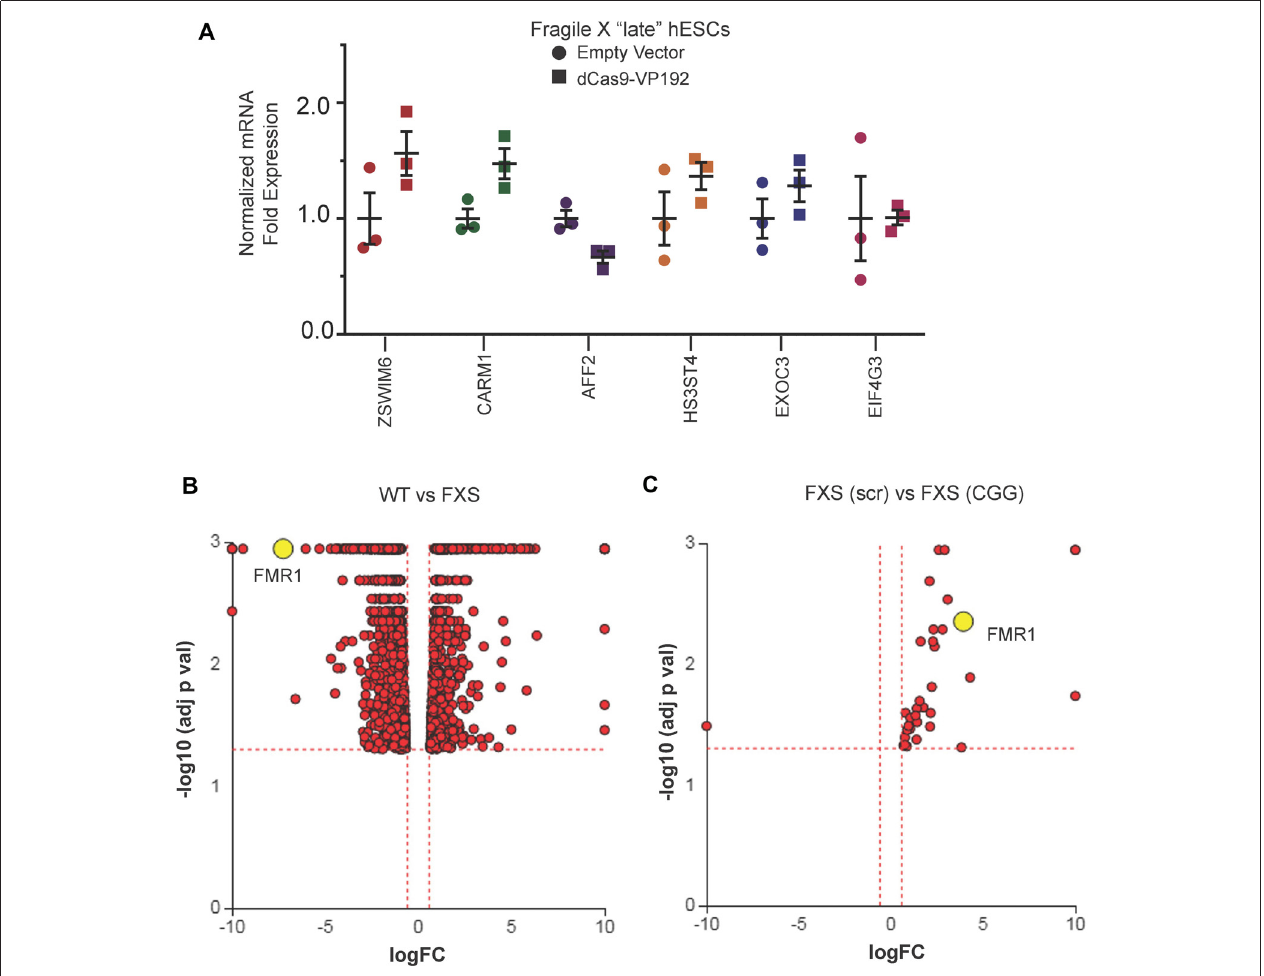
FIGURE 7 | Targeted reactivation of FMR1 by CGG guide RNAs has minimal off target effects compared to scramble guide RNA. (A) Relative fold expression of select CGG repeat-containing genes after transfection of late passage FXS hESCs with CGG gRNA and eGFP (empty vector) or dCas9-VP192 constructs. Each data point represents a technical replicate and error bars represent SEM. (B) Volcano plot showing RNA-seq analysis of WT and FXS hESCs. All 1784 significant differentially expressed (DE) genes are represented in terms of their measured fold change ( x -axis) and the significance represented as the negative log (base 10) of the p -value ( y -axis). The yellow dot shows the position of FMR1 mRNA. (C) Volcano plot showing RNA-seq analysis of FXS (scramble gRNA treated) and FXS (CGG gRNA treated) late passage hESCs expressing dCas9VP192. All 35 DE genes are represented as in terms of fold change. The axes are as described in (B) . Yellow dot represents position of FMR1 mRNA. Images (B,C) were obtained from iPathwayGuide